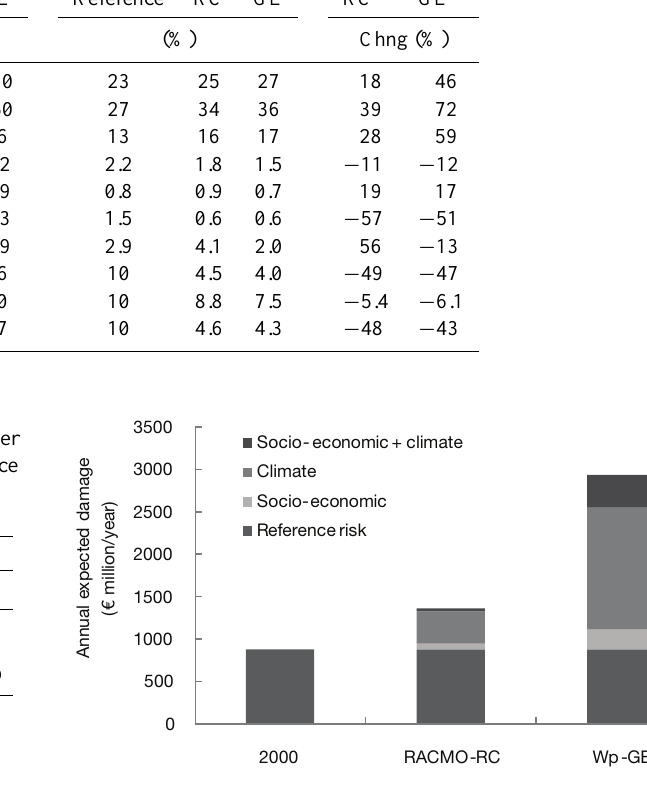
Fig. 6. Basin-wide annual expected flood damage (risk) for 2030, compared to the reference